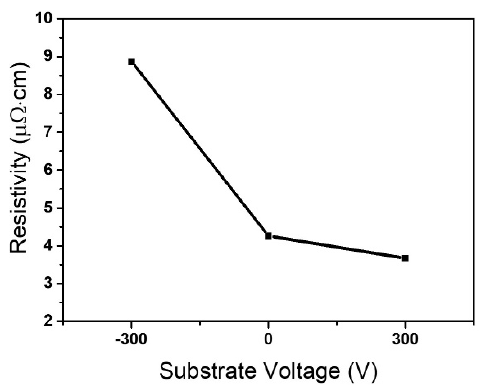
Figure 10. Resistivity of the Ag films deposited at the electric biases of − 300, 0 and + 300 V.